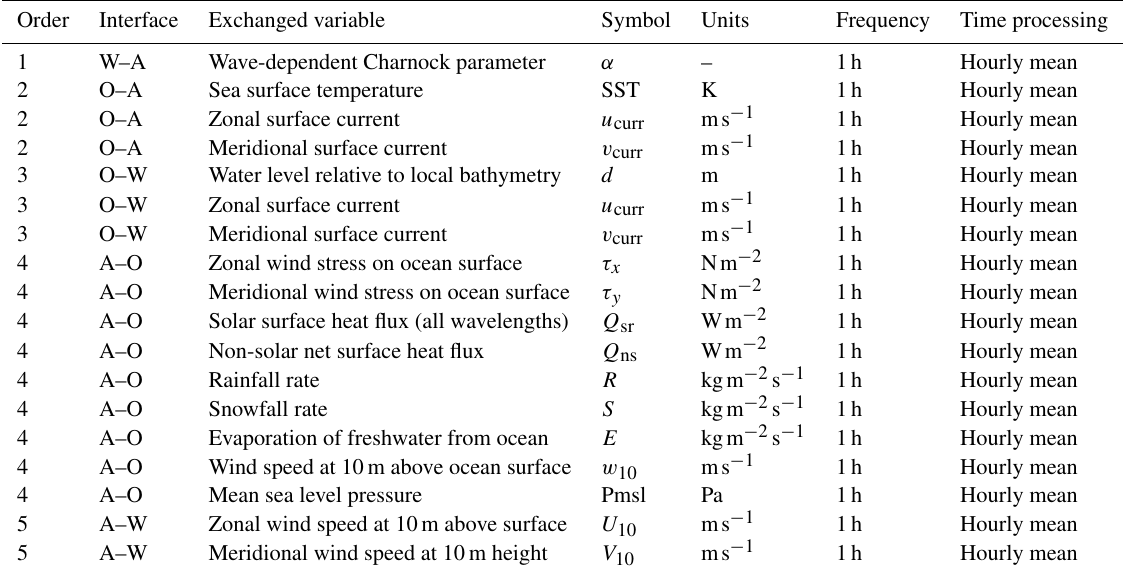
Table 1. Summary of coupling exchanges between atmosphere/land (A), ocean (O) and wave (W) components within the UKC2 coupled prediction system. Ensuring that exchanges occur between model components in the coupling order shown avoids system deadlocks within OASIS3-MCT. The coupling frequency highlights that all fields are currently exchanged every hour of the simulation time, and that all fields are computed as hourly mean values. See Sect. 2 for further